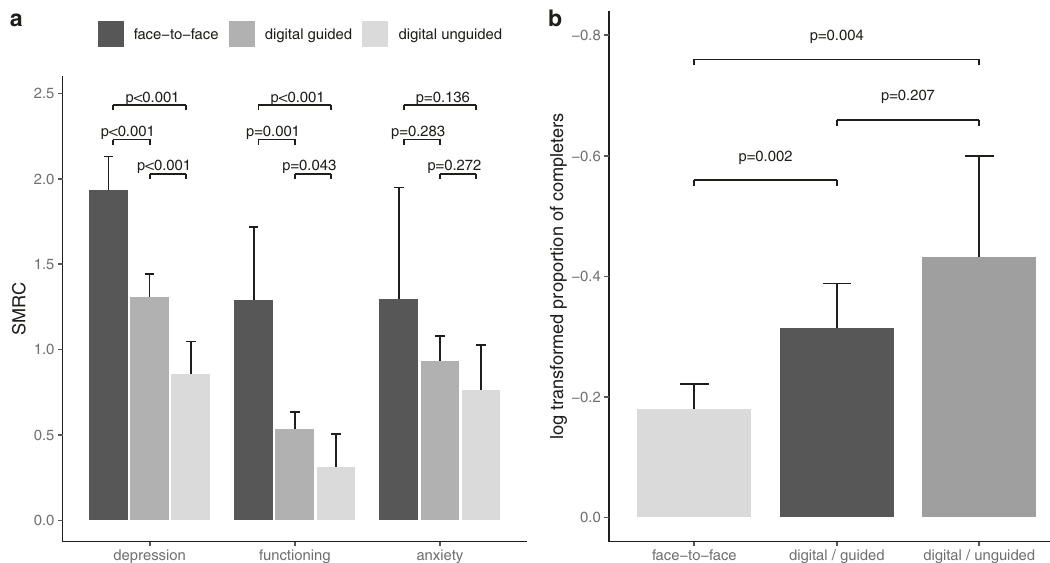
Fig. 3 Comparison of face-to-face, guided digital and unguided digital CBT treatments regarding. a Clinical outcomes following the CBT intervention. b Comparisons of adherence. P values indicate signi fi cance of differences between digital and face-to-face interventions tested by moderator analysis in the meta-analytic model. Error bars indicate lower and upper limits of the 95% con fi dence